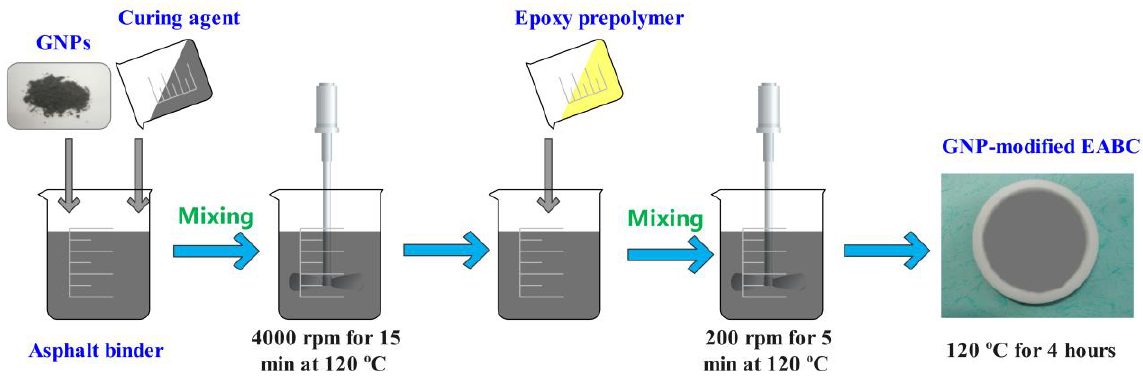
Figure 1. Scheme of the preparation of GNP-reinforced EABC.